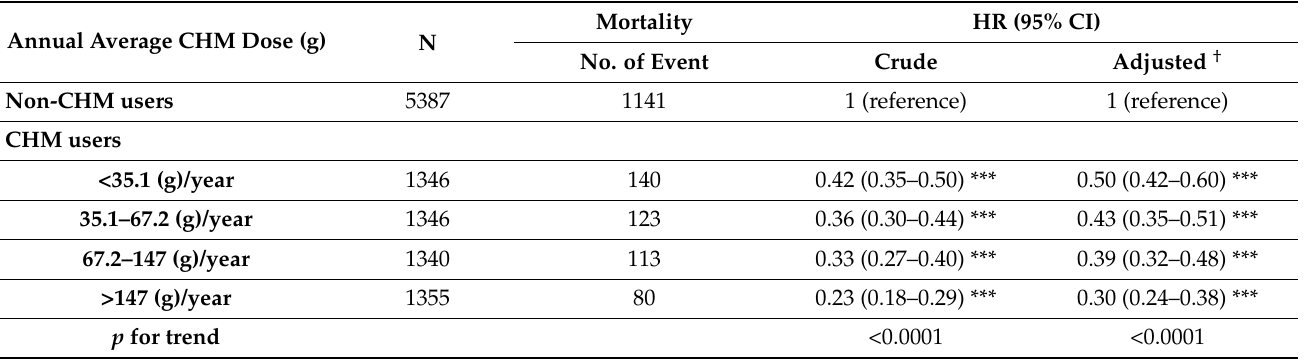
Table 4. The risk of mortality rate stratified by the annual average CHM dose among breast cancer